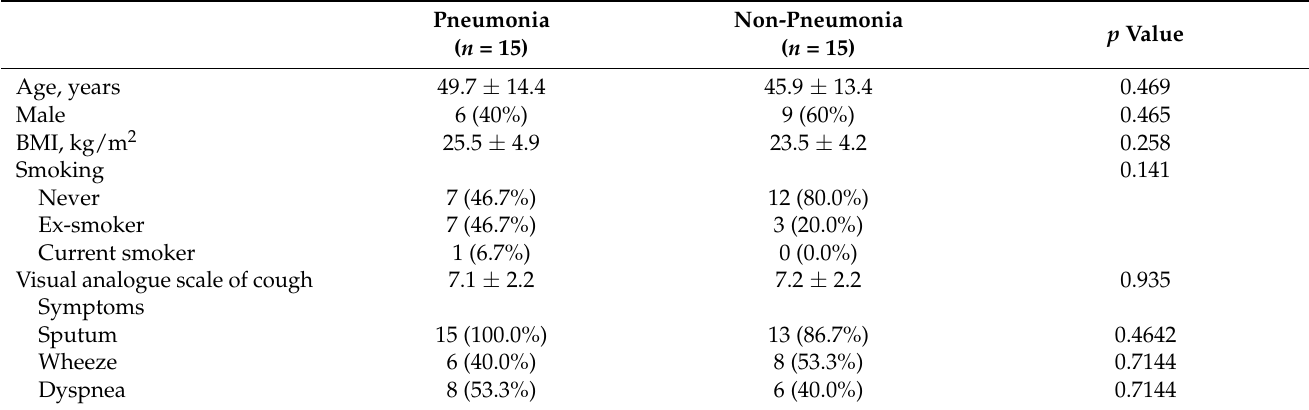
Table 2. Descriptive characteristics of the study population. Continuous values are presented as mean ± SD, and categorical variables are presented as number (%). Cough severity was measured using visual analogue scale from 0 to 10